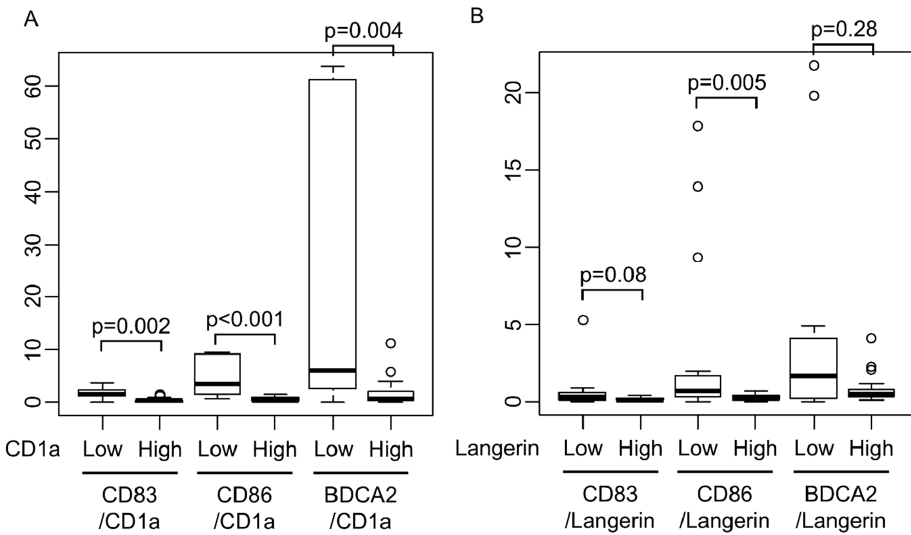
Figure 7. Mature DC ratio in DC-high and DC-low cases. CD83/CD1a ratio and CD86/CD1a ratios were significantly lower in CD1a-high cases than in CD1a-low cases ( A , p < 0.01, determined by using Wilcoxon rank sum test). The similar result was also obtained in Langerin ( B , p = 0.08 and p = 0.005, respectively, Wilcoxon rank sum test).